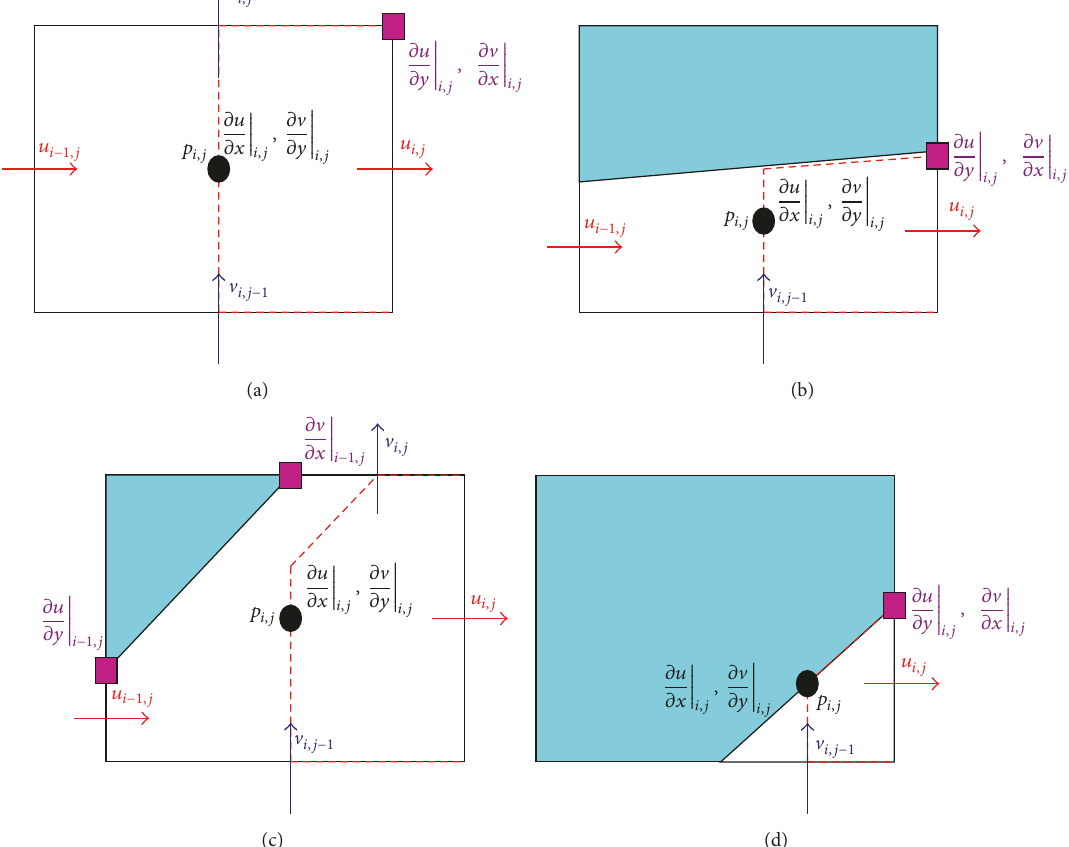
Figure 4: Locations of the variables discretization points in case of generic cells on the modified LS-STAG mesh: (a) Cartesian fluid cell; (b) north trapezoidal cell; (c) northwest pentagonal cell; (d) northwest triangle cell.